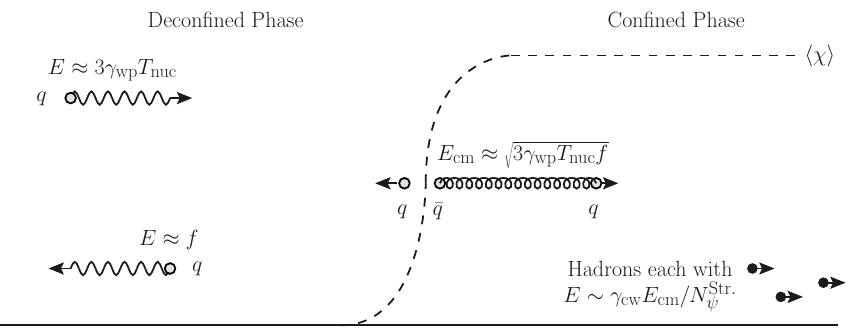
Figure 5 . The string formation and fragmentation mechanism as seen in the wall frame. Highly energetic quarks impinge on the wall, leading to a string-like flux configuration. Its centre-of-mass energy is set by geometric mean of the initial quark energy and the energy of the quark ejected from the end of the string. The latter is taken to be of the order of the strong scale. The fragmentation of the string forms hadrons in the confined phase. The fact that the string is attached to the moving wall acts as a catapult for said hadrons which are then boosted with respect to the plasma